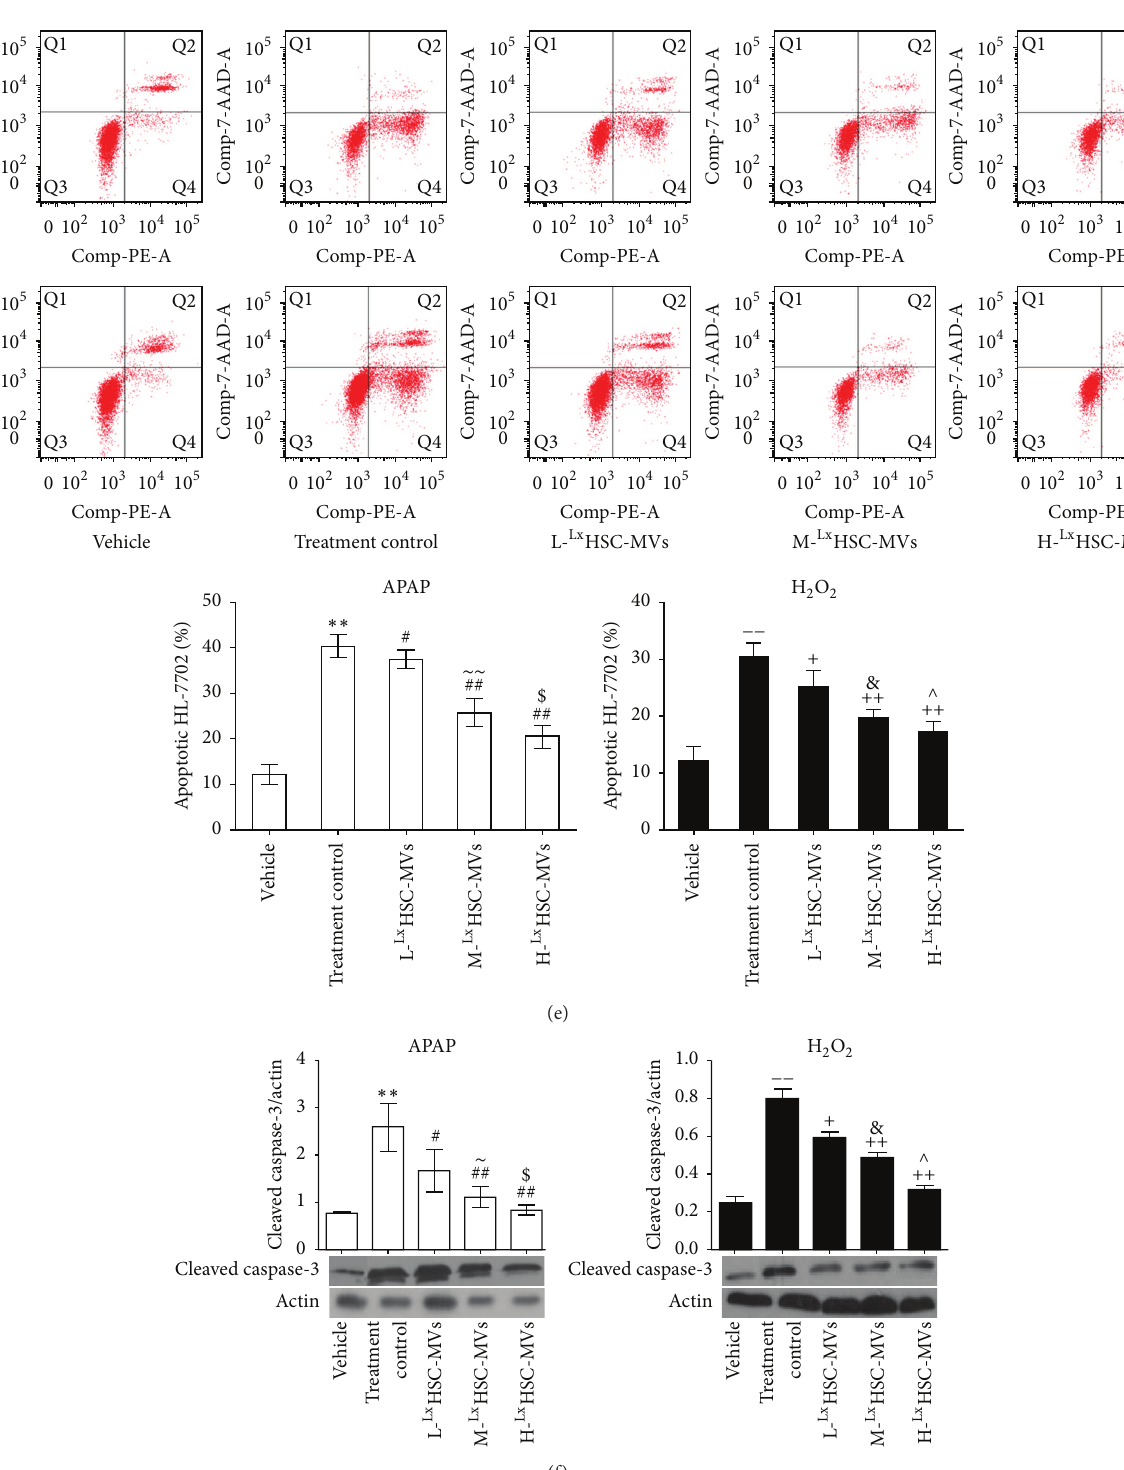
Figure 3: Effect of HSC-MVs on APAP or H 2 O 2 -treated BRL-3A and HL-7702 apoptosis and cleaved caspase-3 expression. (a) BRL-3A apoptosis monitored by Hoechst 33258 staining (red arrows represent apoptotic cells, green arrows represent normal cells). (b) BRL-3A apoptosis determined by flow cytometric analysis. (c) Expression of cleaved caspase-3 protein in BRL-3A. HL-7702 apoptosis detected by Hoechst 33258 staining (d) and flow cytometric analysis (e). (f) Expression of cleaved caspase-3 protein in HL-7702. ∗∗ 𝑝 < 0.01 versus vehicle, APAP; −− 𝑝 < 0.01 versus vehicle, H 2 O 2 ; # 𝑝 < 0.05 , ## 𝑝 < 0.01 versus treatment control, APAP; + 𝑝 < 0.05 , ++ 𝑝 < 0.01 versus treatment control, H 2 O 2 ; ∼∼ 𝑝 < 0.01 versus L-HSC-MVs, APAP; && 𝑝 < 0.01 versus L-HSC-MVs, H 2 O 2 ; $ 𝑝 < 0.05 , $$ 𝑝 < 0.01 versus M- HSC-MVs, APAP; ∧ 𝑝 < 0.05 versus M-HSC-MVs, H 2 O 2 ; 𝑛 = 3 /group; ∼ represents 𝑝 < 0.05 versus L-HSC-MVs, APAP; & represents 𝑝 < 0.05 versus L-HSC-MVs, H 2 O 2